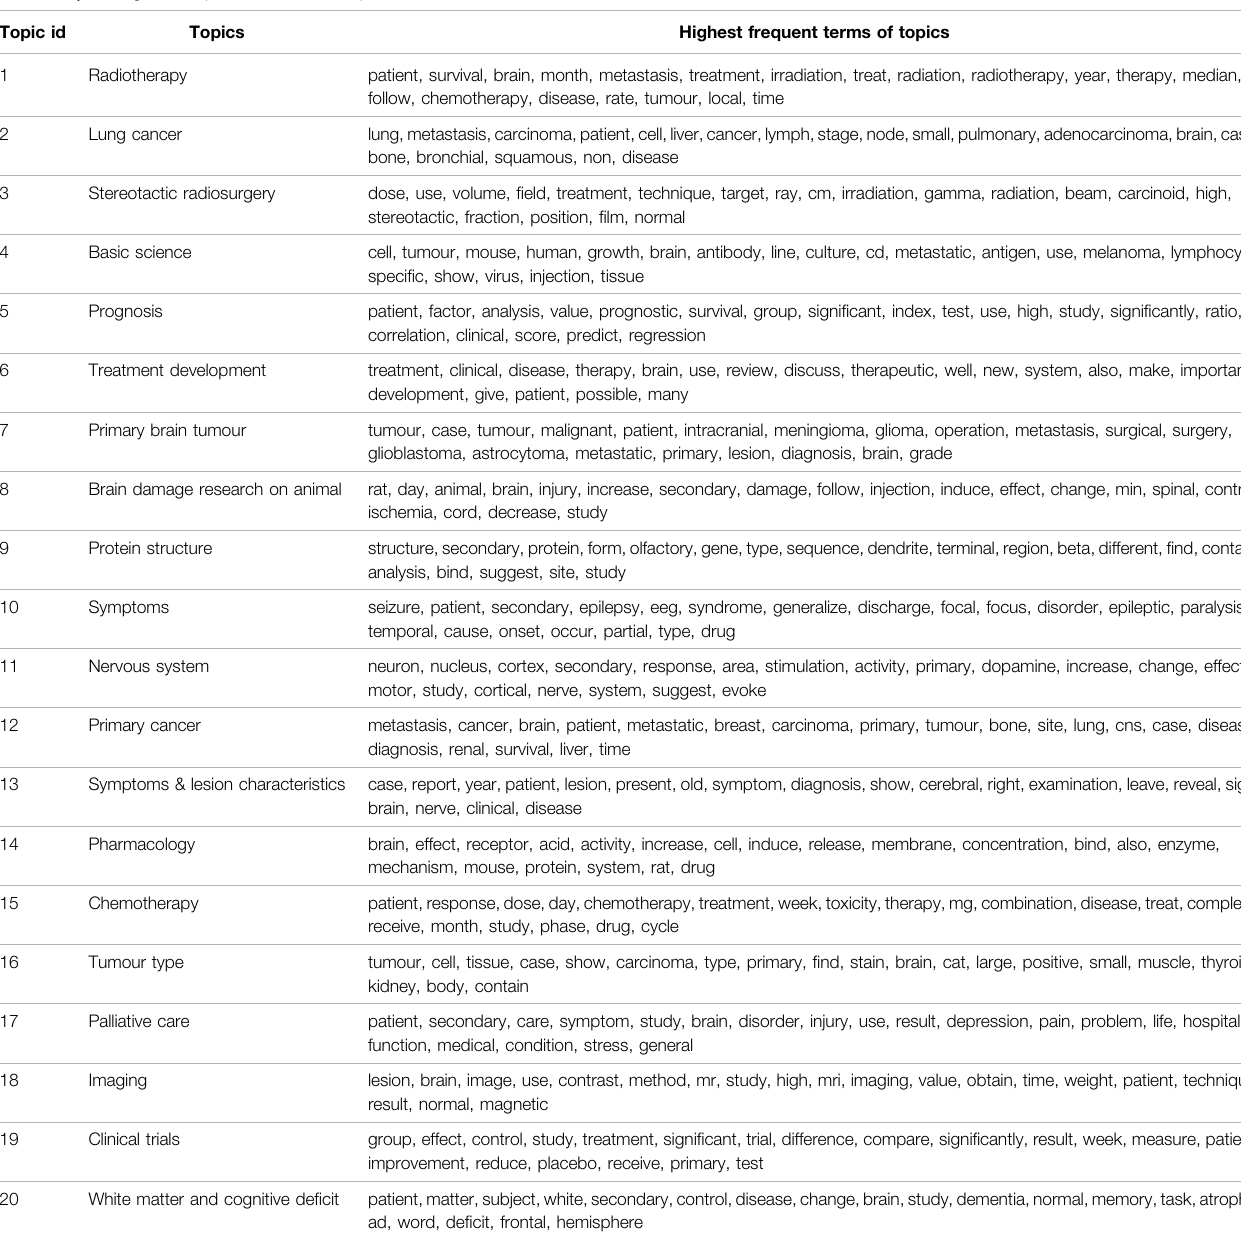
TABLE 1 | The highest frequent terms for 20 topics of the brain metastases-related articles. Topic id Topics Highest frequent terms of